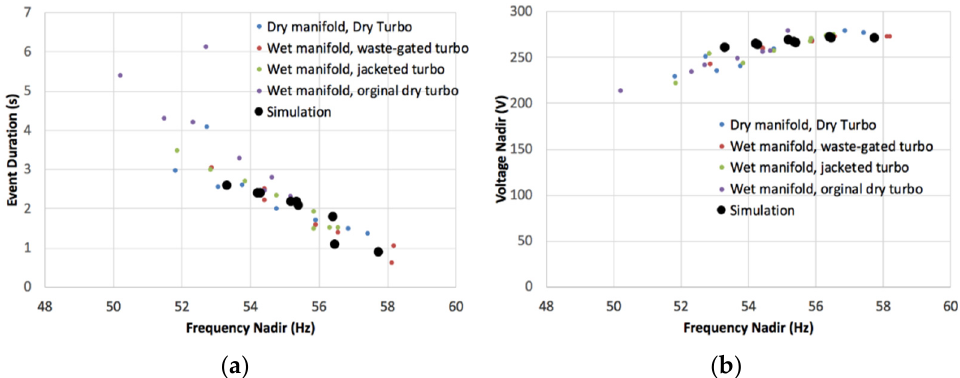
Figure 2. MATLAB Simulations and AVEC’s Experimental Data at Varying Manifold and Turbo Conditions. ( a ) Event duration vs. frequency nadir. ( b ) Voltage nadir vs. frequency nadir.